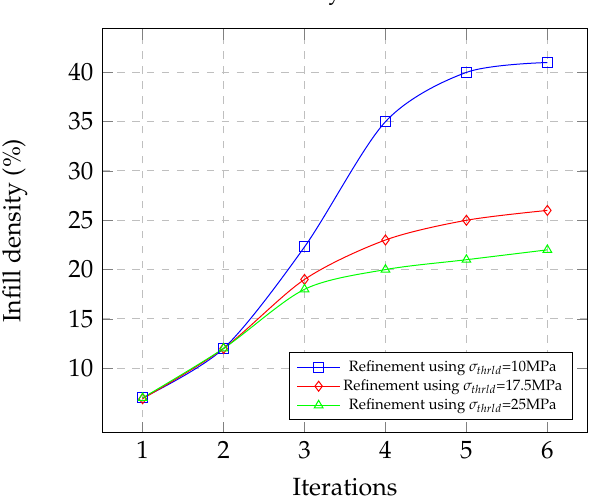
Figure 11. Infill density during each